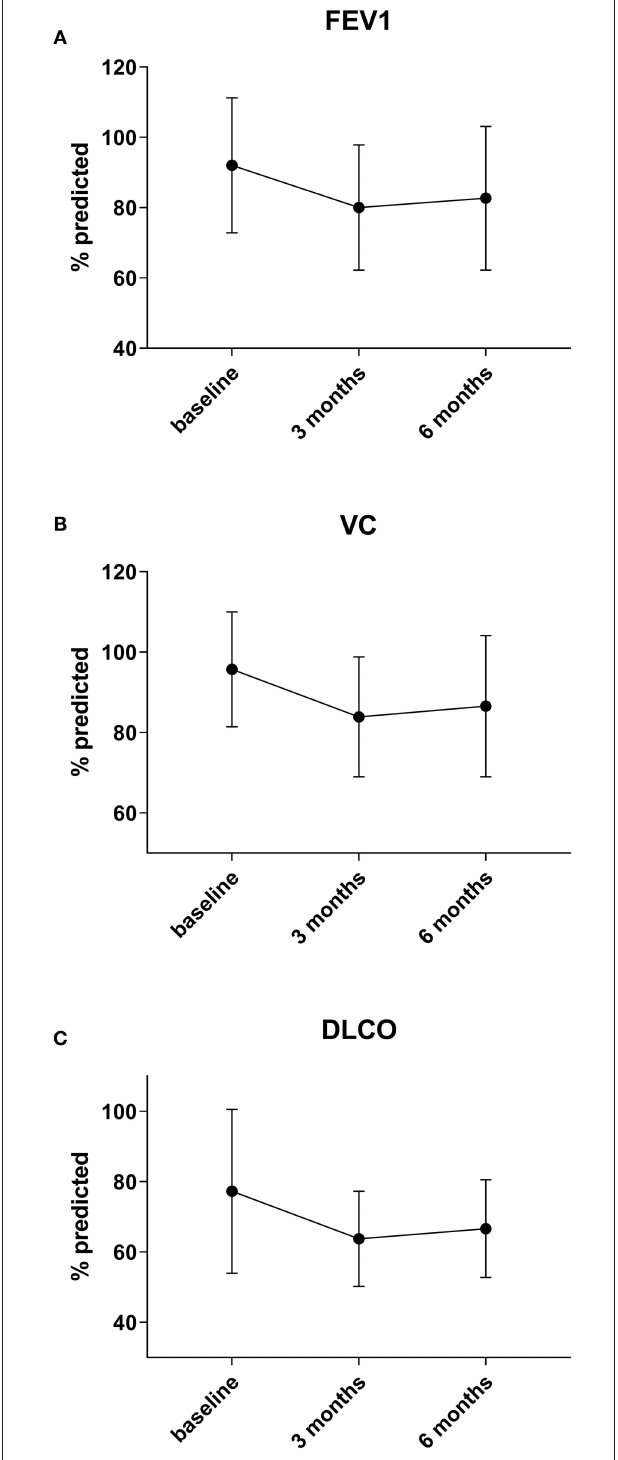
FIGURE 1 | Preoperative lung function parameters show a near normal respiratory function in the cohort. Three months after surgery a decline of mean forced expiratory volume in 1 second (FEV1) by 11% (A) , vital capacity (VC) by 11% (B) , and median DLCO by 11% (C) (all p < 0.0001) is observed. There is no significant change of lung function after three months